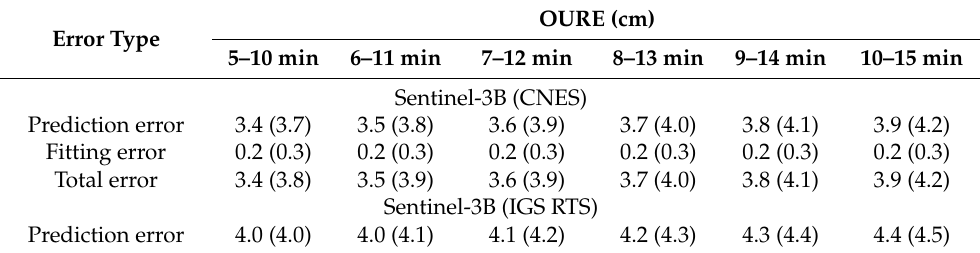
Table 11. Total error budget (in OURE) of the real-time LEO satellite orbits. The values are given for different prediction time windows. The results without outlier exclusions are given in